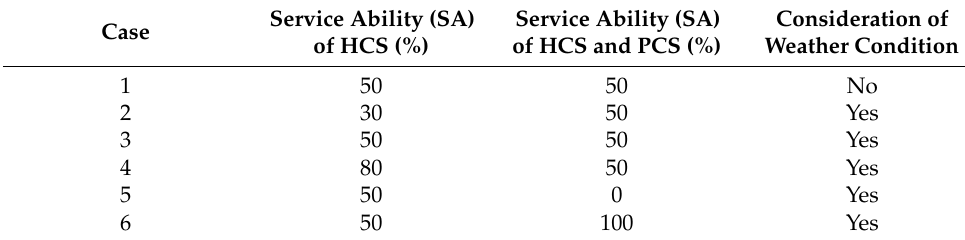
Table 4. Various constraints of placement problem.